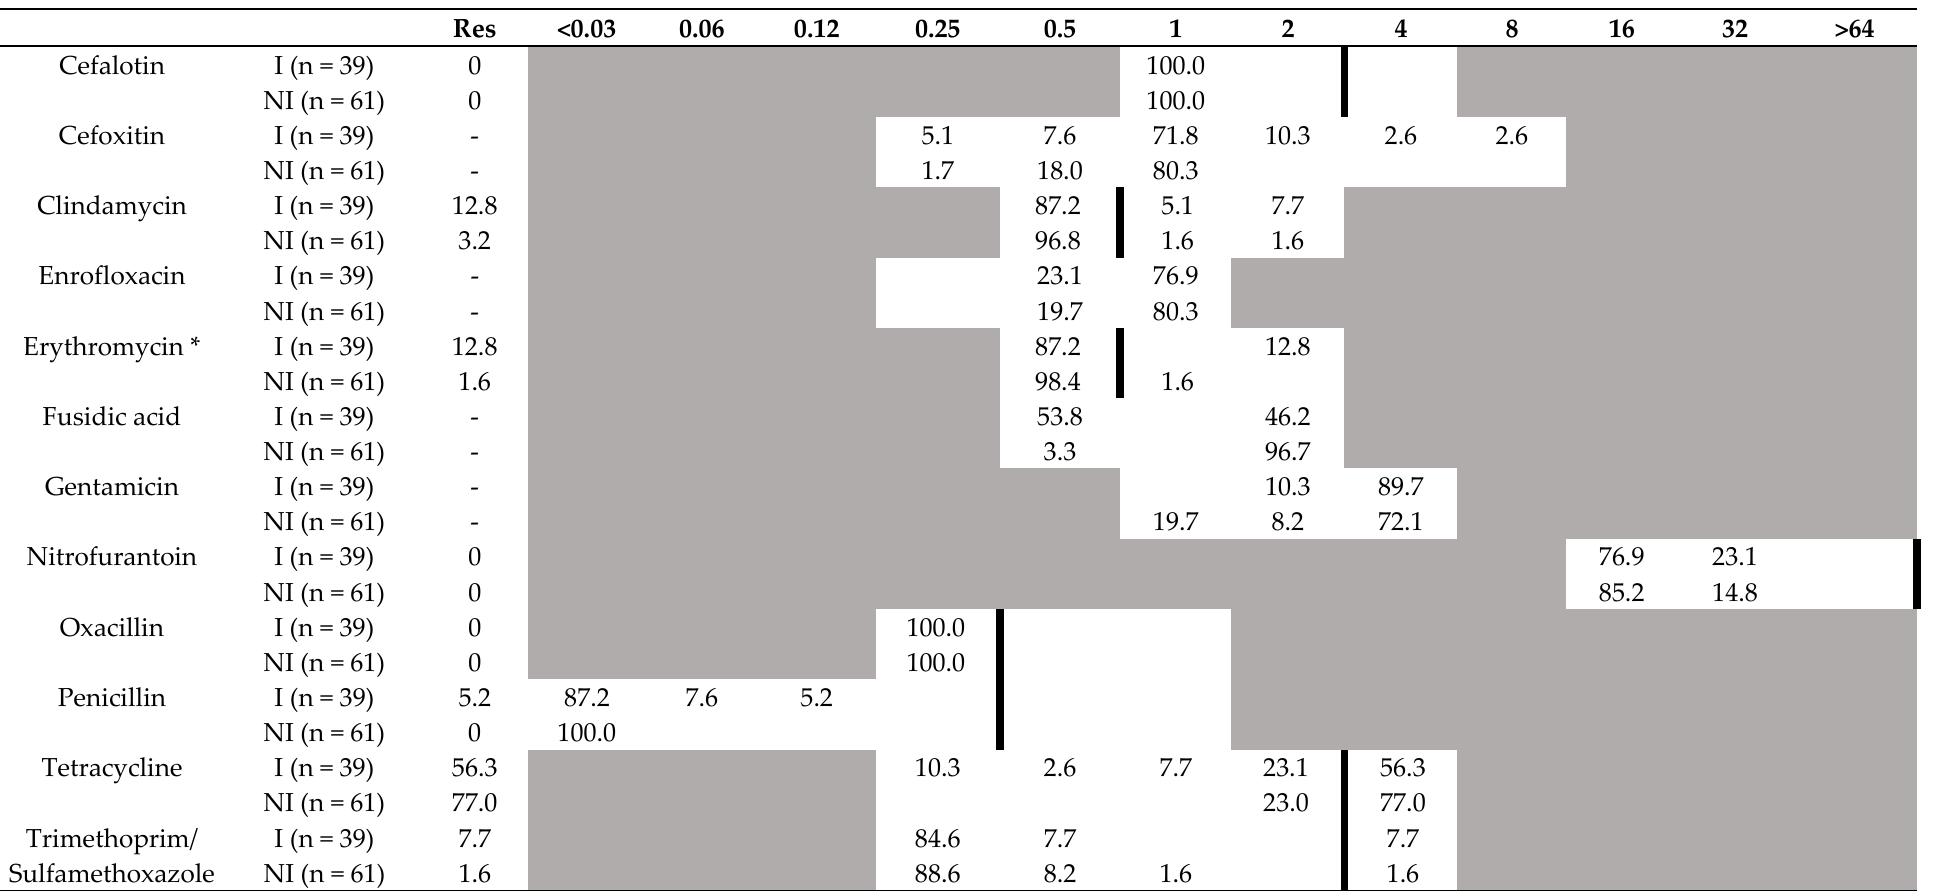
White fields denote the range of dilutions tested for each antibiotic and bold vertical lines indicate the cut-off values used to define resistance. Grey fields denote the range outside of the dilutions tested. MICs equal to or lower than the lowest concentration tested are given as the lowest tested concentration. - = no cut-off values available. * Denotes a significant difference between inseminated and non-inseminated